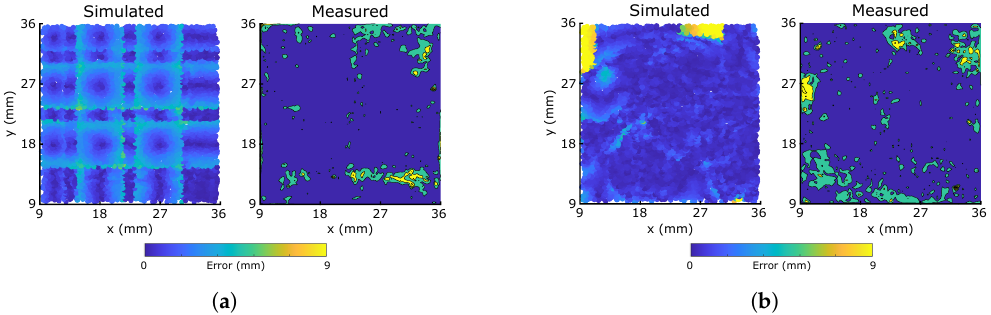
Figure 11. Simulated and measured error distributions for the damaged sensor morphologies, after retraining of the neural networks. The two damaged sensors (see Figure 5) are ignored, and the networks are trained from scratch with only six inputs. ( a ) Grid; ( b ) Optimized.